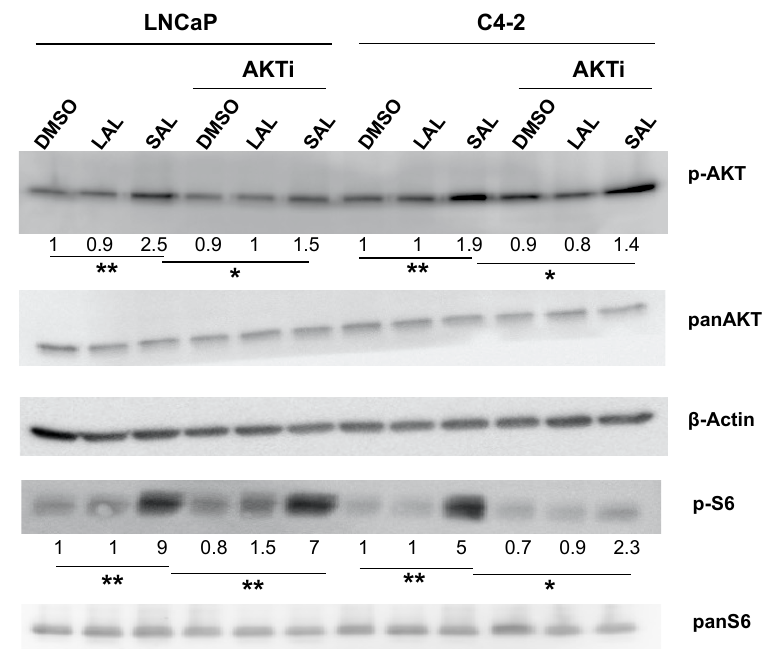
Figure 4. AKTi treatment counteracts the SAL induced p-AKT and p-S6 levels. LNCaP and C4-2 cells were treated with DMSO as solvent control, LAL or SAL with and without AKTi for 72 h. Protein extracts were used for Western blot for detection of p-AKT and pS6. Numbers below the bands indicate the intensities normalized to β -Actin bands as loading control with statistical significance (n = 3).